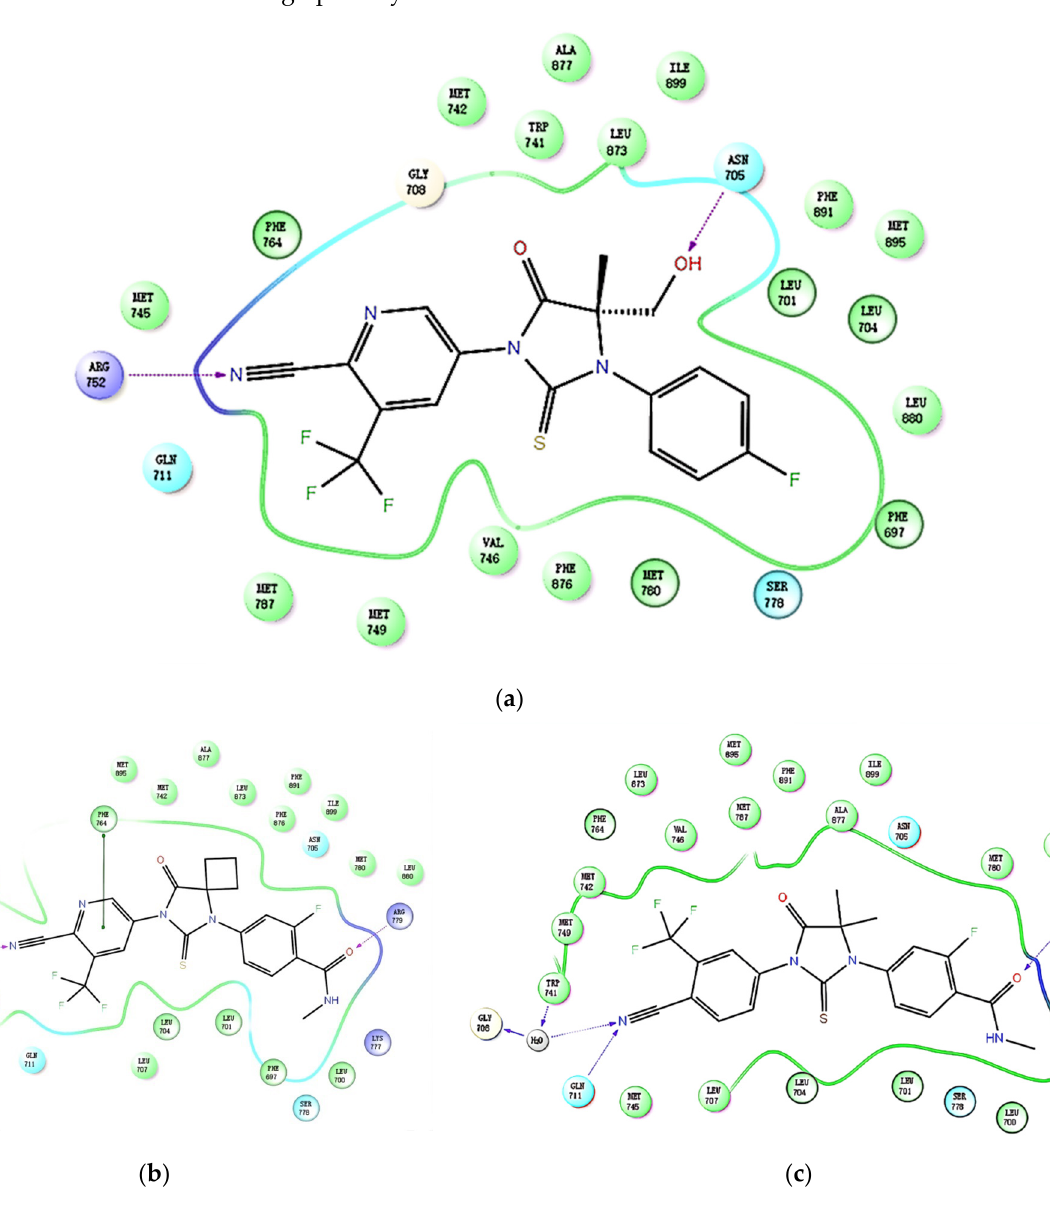
Figure 3. The predicted binding modes and 2D diagram of ( a ) compound 19b ; ( b ) apalutamide and ( c ) enzalutamide in complex with AR (PDB ID: 2OZ7).